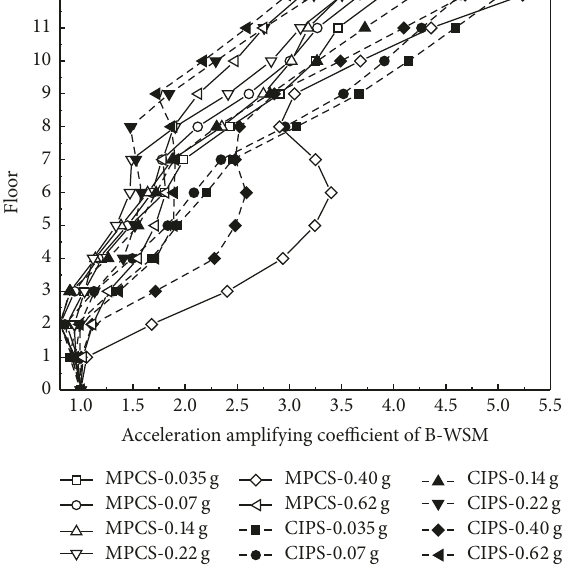
Figure 10: Acceleration amplifying factors of CIPS and